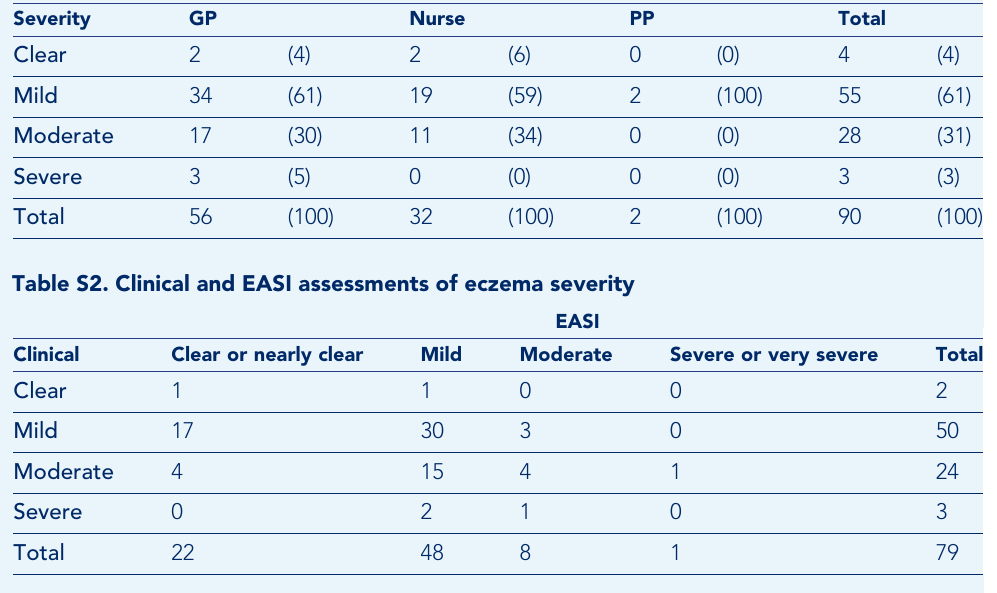
Table S3. Clinical and POEM assessments of eczema